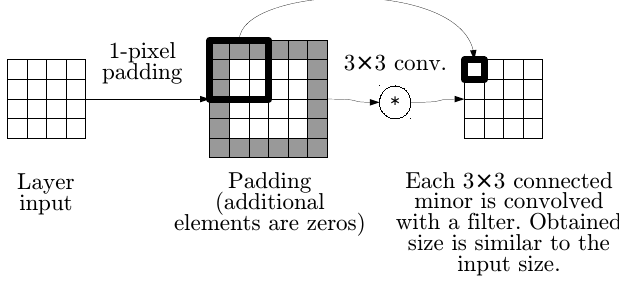
Figure 1. The operation illustrated in this figure is a superposition of 1 × 1 zero-padding and matrix convolution with 3 × 3 filters. As the padding size matches the filter size properly, the output matrix has the same size as the input matrix.